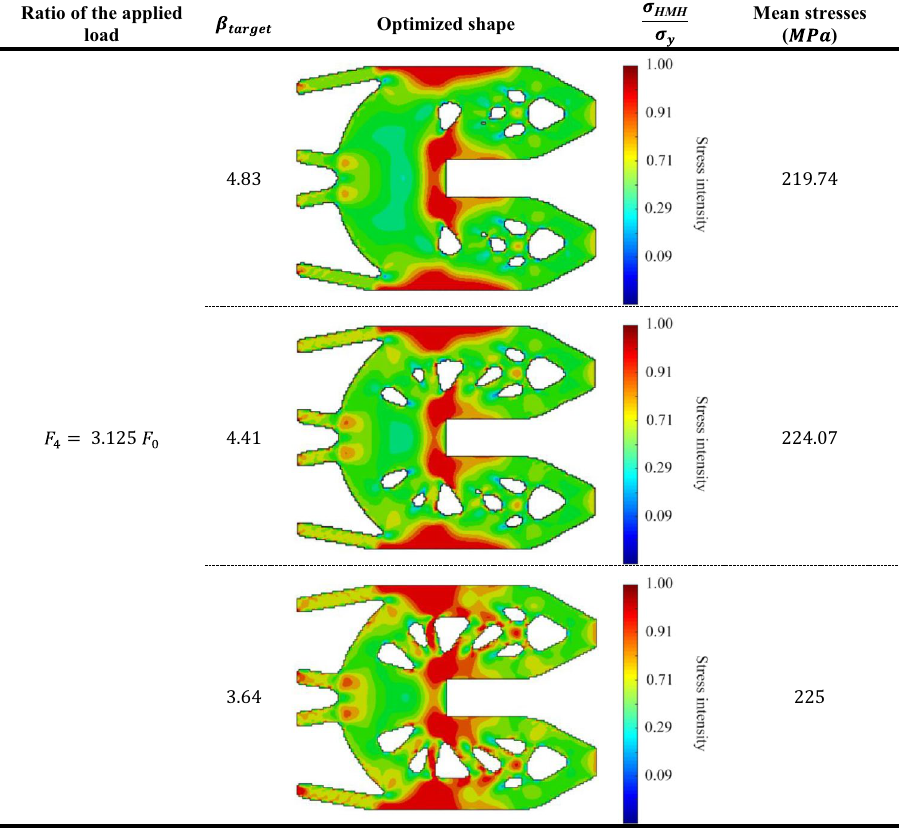
Table 10. HMH stresses and optimum topologies according to various load